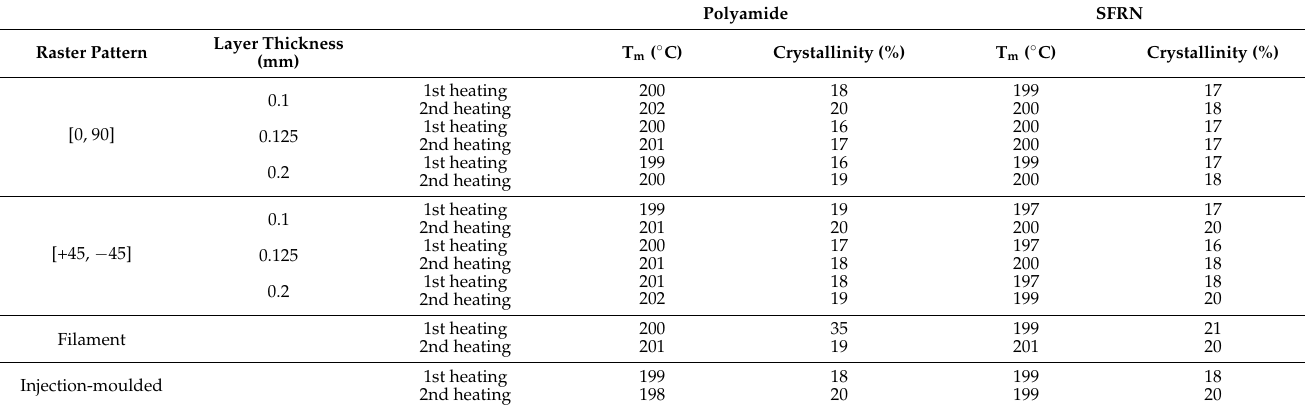
Table 3. The crystallinity and melting temperature of filaments, fabricated polyamide and SFRN